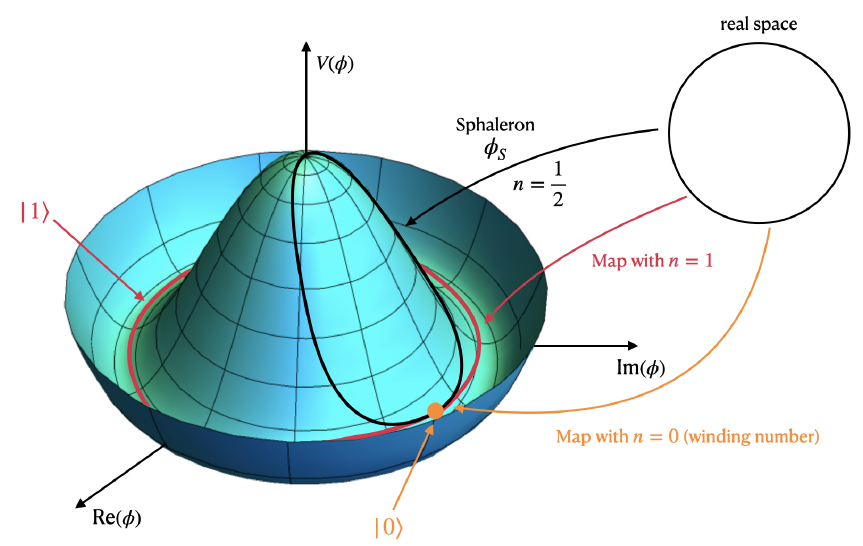
Figure 3. Representation in the scalar field space of the two vacua solutions | 0 (cid:105) , | 1 (cid:105) and also the solution connecting them, known as the sphaleron, which has an unstable direction. The sphaleron and the vacua appear as a mapping between the real space and a circle in the field space. The homotopy class associated will be non trivial π 1 ( S 1 ) = Z , where this number is often known as the winding number.